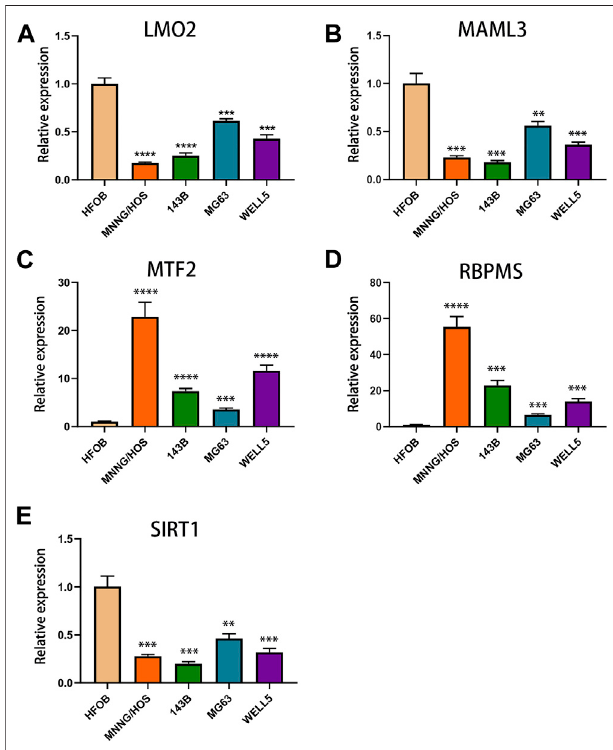
FIGURE 7 | Expressions of TcoF-related genes in osteosarcoma and osteoblast cell lines. (A) Expression ofLMO2 in osteosarcoma and osteoblast cell lines. (B) Expression ofMAML3 inosteosarcoma and osteoblast cell lines. (C) Expression of MTF2 in osteosarcoma and osteoblast cell lines. (D) Expression of RBPMS in osteosarcoma and osteoblast cell lines. (E) Expression of SIRT1 in osteosarcoma and osteoblast cell lines. ** p < 0.01; *** p < 0.001; **** p < 0.0001.